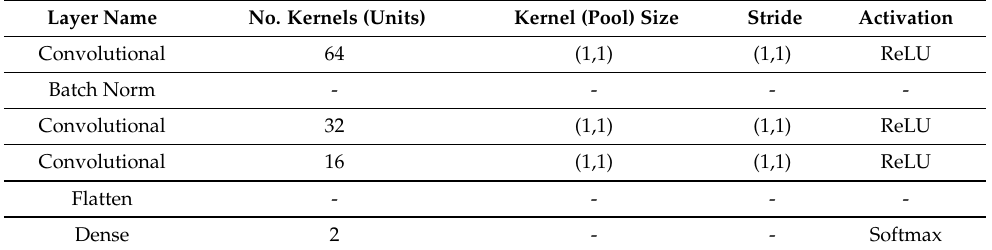
Table 4. CNN architecture with a fixed dropout rate of 0.5 and learning rate of 10 − 4 .